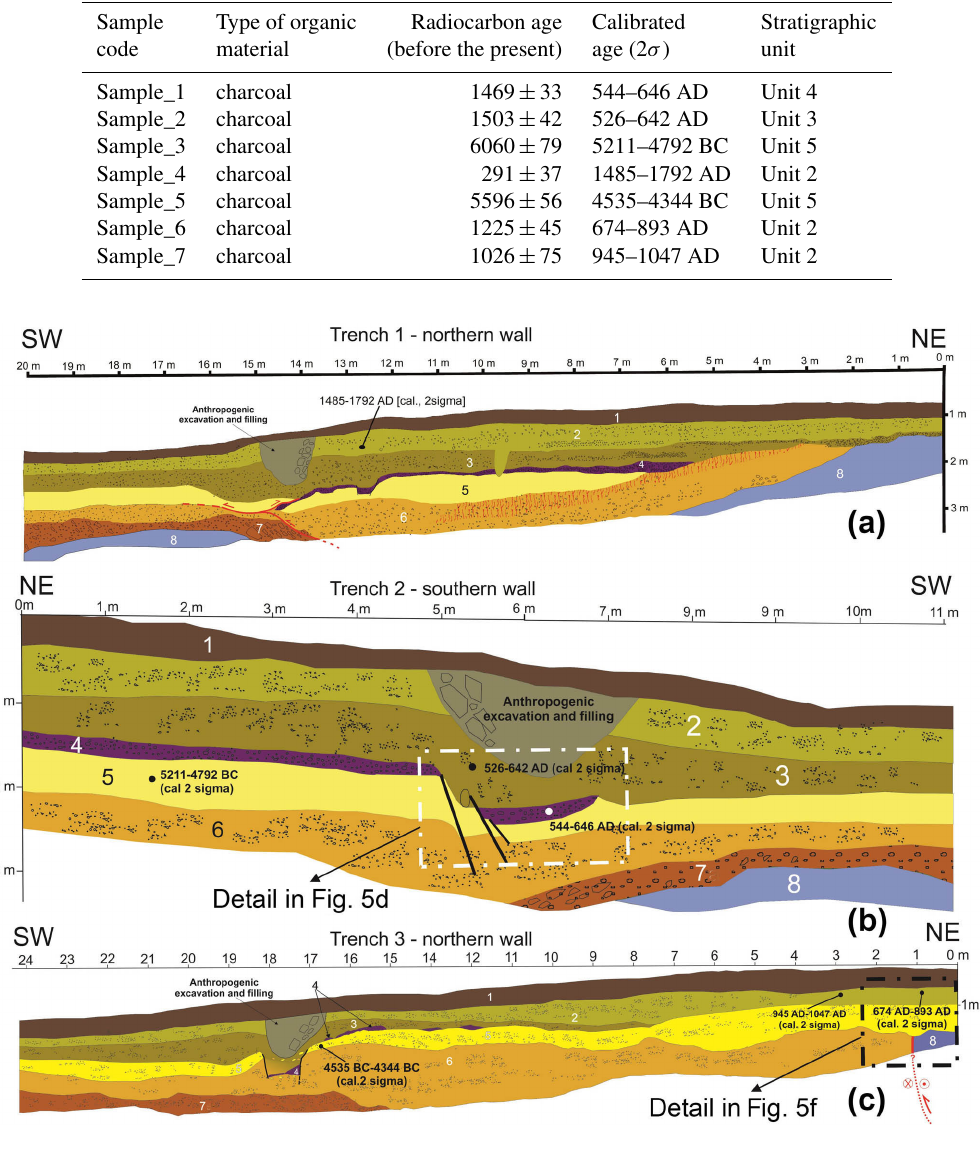
Figure 6. Trench walls, stratigraphic schemes. Units: 1, soil; 2, 3, 5 and 6, colluvial deposits; 4 and 7, fluvial deposits; 8, turbiditic